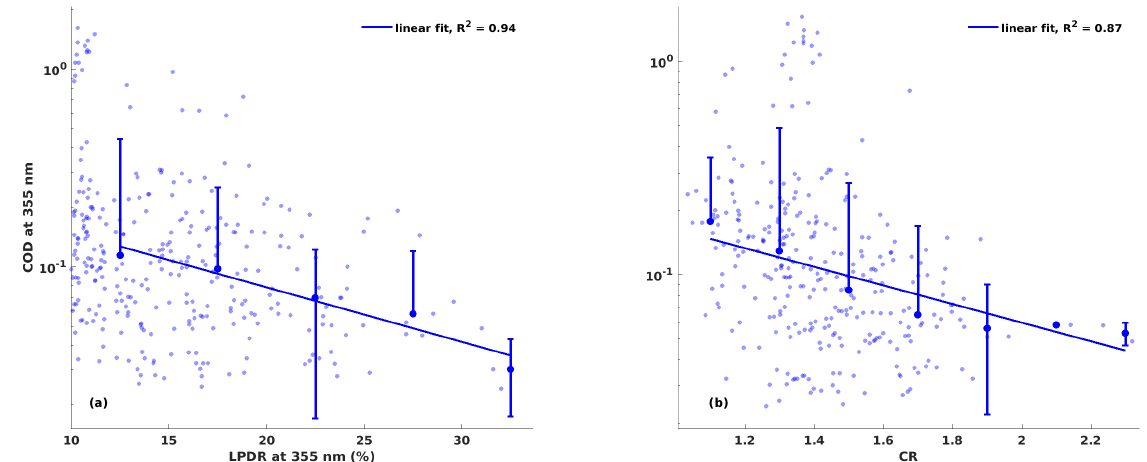
Figure 8. COD versus LPDR ( a ) and CR ( b ). The median ± standard deviation of COD in 5% LPDR and 0.2 CR classes is also given. The linear regression curve on the median values is overlaid only if the coefficient of determination ( R 2 ) exceeded 0.5.